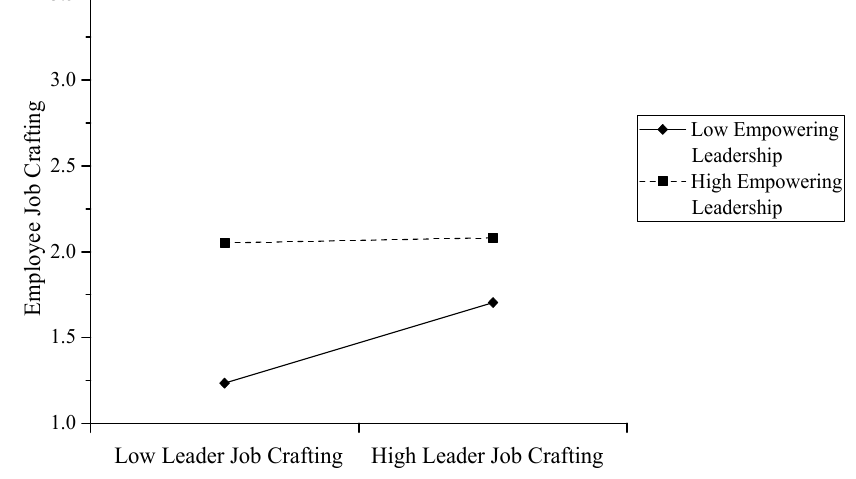
Figure 3. Moderated mediation effect of empowering leadership. Table 3. Results of moderated mediation effects.